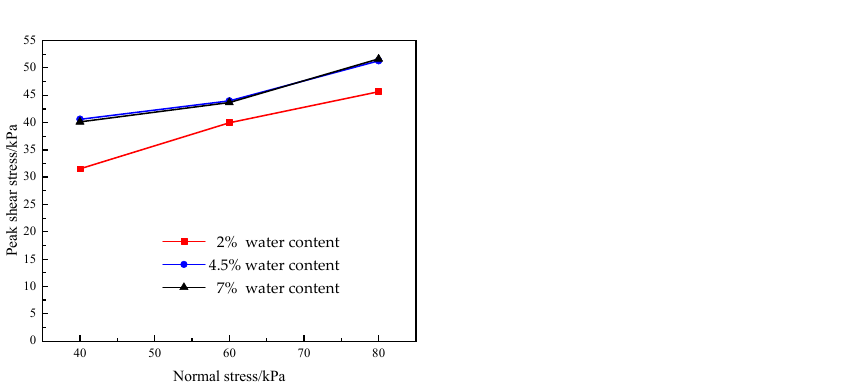
Figure 13. The influence of water content on the peak shear stress of the reinforced soil interface under the freezing state ( − 5 °C). 3.3. Influence of Water Content and Temperature on the Shear Strength Index of the Reinforced Soil Interface To study the influence of the water content and temperature variables on the shear strength between the geogrid and coarse-grained soil interface, the peak shear stress cor- responding to normal stresses of 40 kPa, 60 kPa and 80 kPa under each working condition is linearly fitted. The parameters are shown in Table 3. The shear relationship of the rein- forced soil interface conforms to the Mohr ‒ Coulomb strength criterion. The normal stress